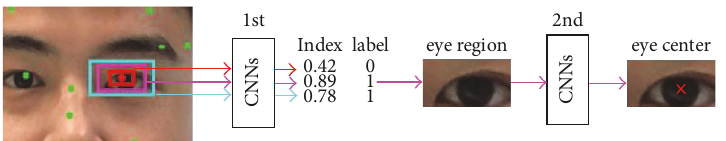
Figure 7: CNNs’ output. The green points represent the selected eye candidate feature points. The indexes show the confidences and the regions predicted by the first set of CNNs. The magenta rectangle was selected as the final prediction result because it had the highest index, 0.89, and this eye was predicted to be the left eye. The eye region was fed into the second set of CNNs outputting the accurate eye center. The red cross represents the eye